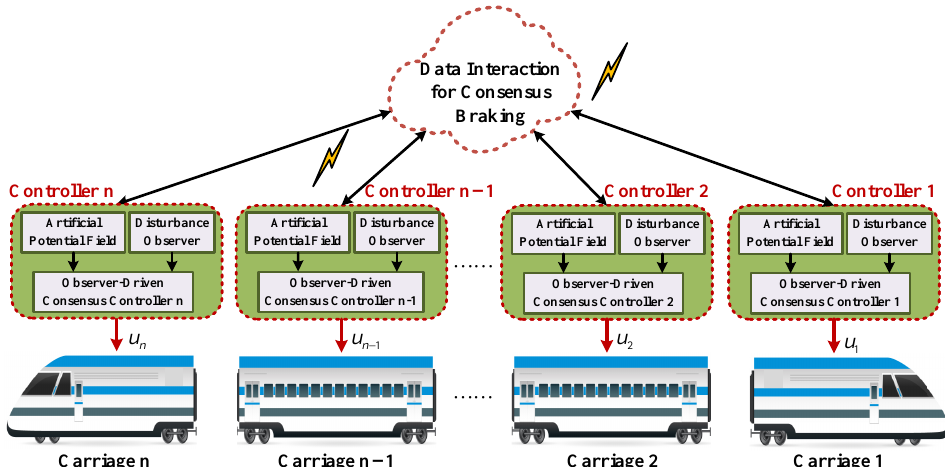
Figure 2. Proposed observer-driven distributed consensus braking control approach for an urban railway